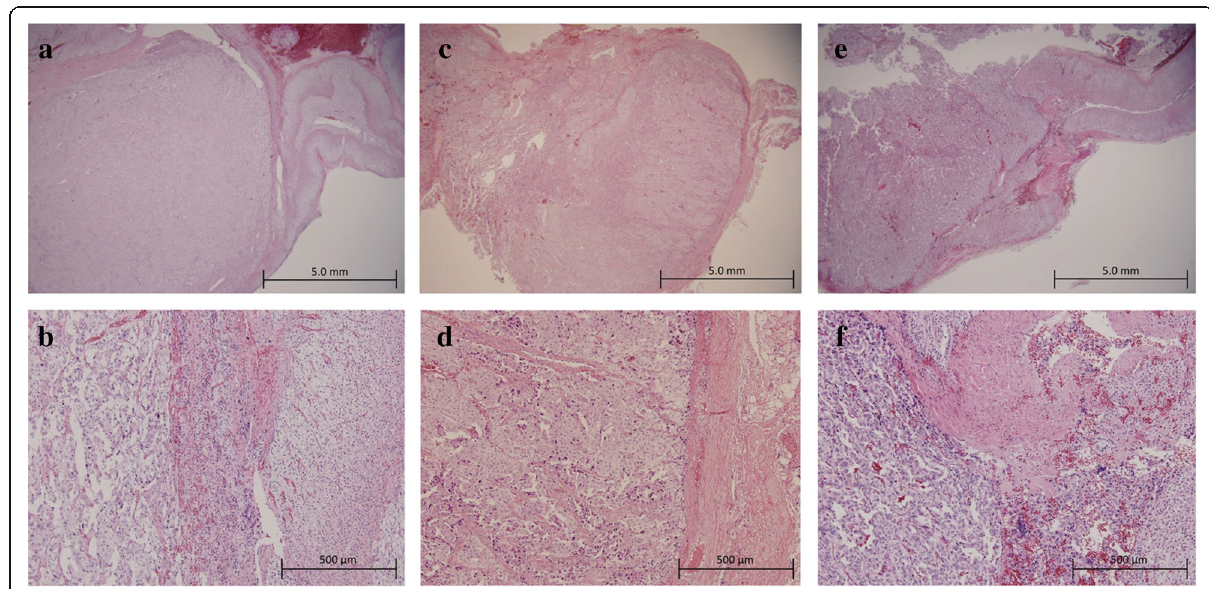
Fig. 3 Histopathological results of resected PPGLs (hematoxylin-eosin staining). a , b Left pheochromocytoma resected in the first operation ( a low magnification, b high magnification). c , d Paraganglioma in the left hilus resected in the first operation ( c low magnification, d high magnification). e , f Right pheochromocytoma resected in the second operation ( e low magnification, f high